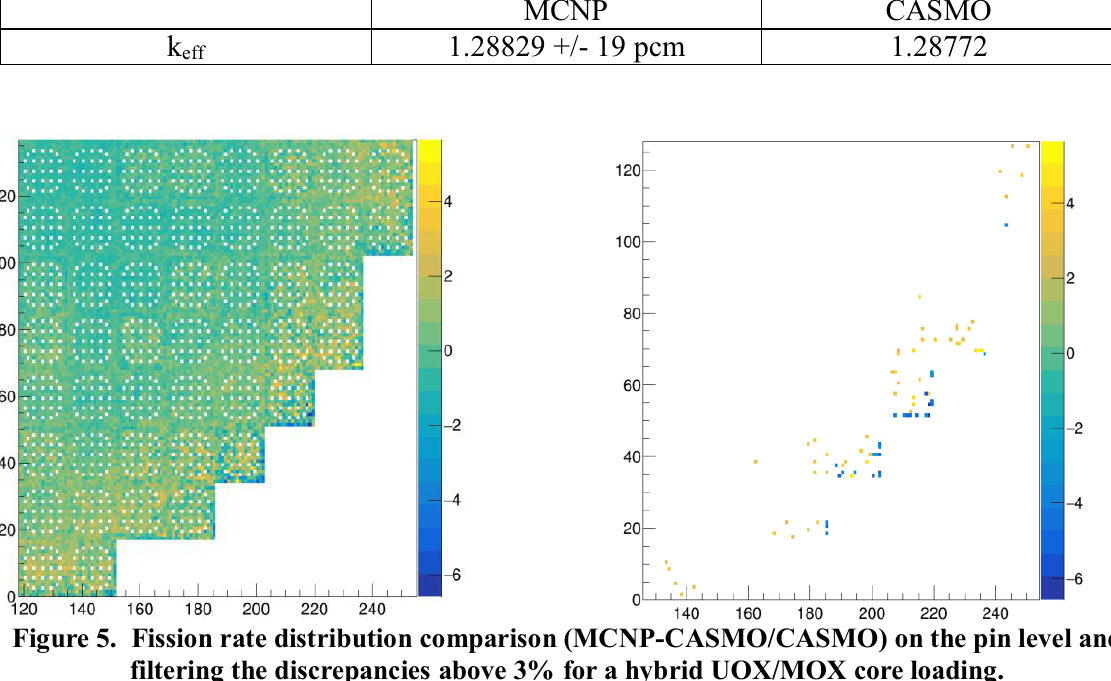
Table II. Multiplication coefficient for UOX/MOX core: MCNP and CASMO results.